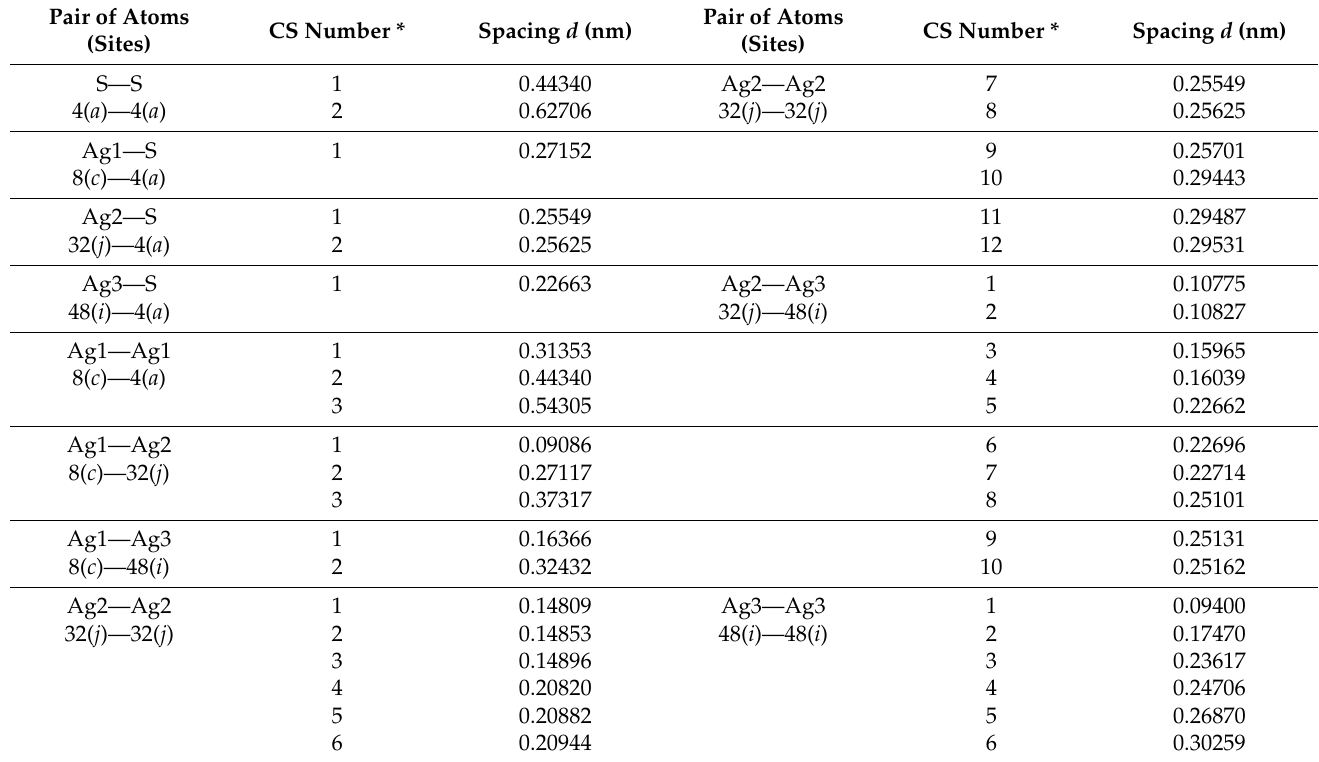
Table 4. Interatomic (interstitial) spacings d for fcc (space group Fm 3 m ) γ -Ag 2 S phase at a 863